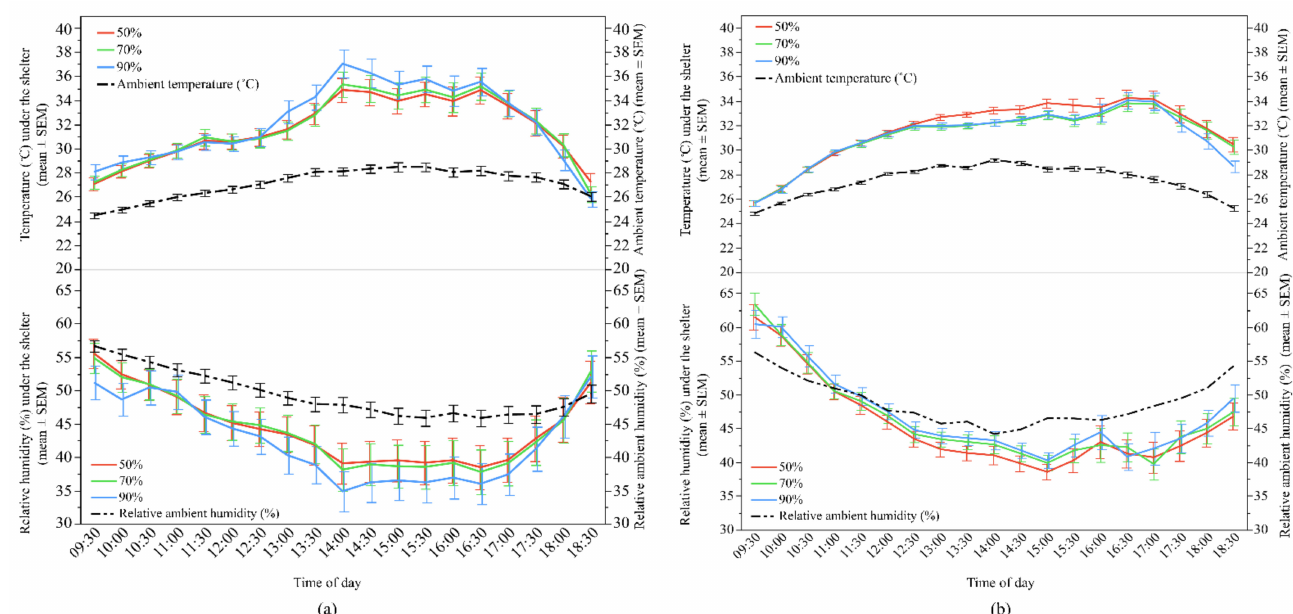
Figure 5. The mean ( ± SEM) temperature and relative humidity throughout the day underneath the shelters of different UV-filtering percentages (50%, 70%, and 90%) and ambient temperature and relative humidity: ( a ) Flock-A: temperature under the shelters and ambient temperature ( top ), relative humidity under the shelters and relative ambient humidity ( bottom ); ( b ) Flock-B: temperature under the shelters and ambient temperature ( top ), relative humidity under the shelters and relative ambient humidity ( bottom ). Raw values are presented with analyses conducted on transformed